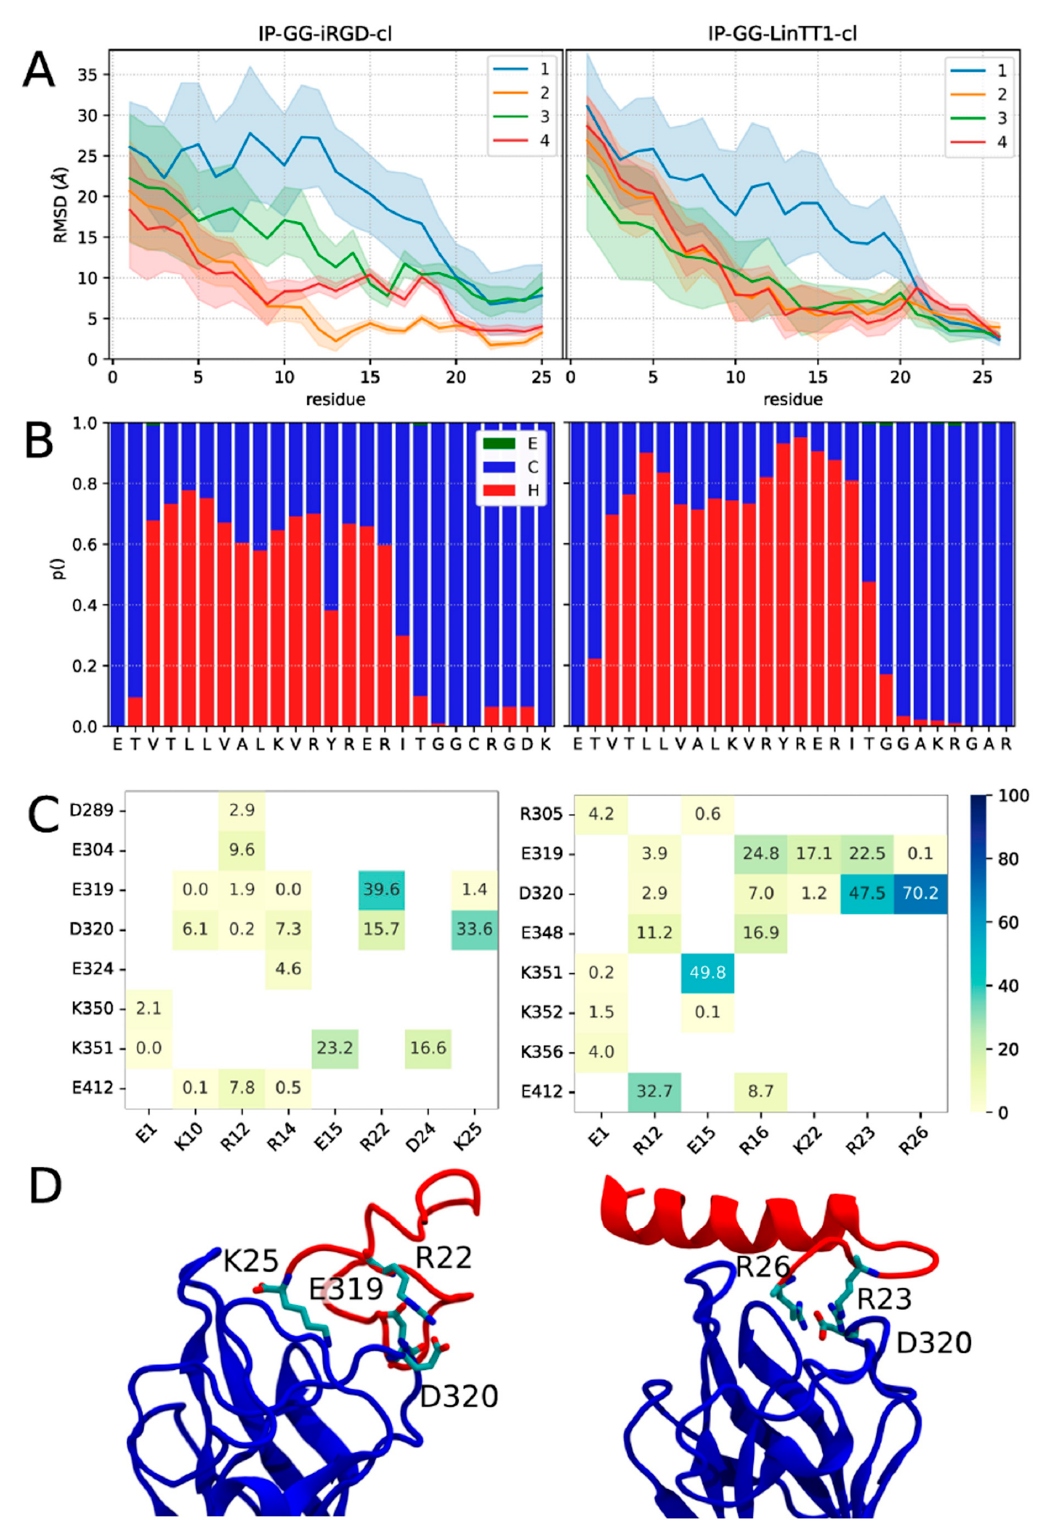
Figure 2. Cleaved Peptide stability secondary structure and interaction with Neuropilin1. ( A ): Peptide RMSD per residue of IR-GG-iRGD-cl and IR-GG-LinTT1-cl, colored by simulation replica; error bar represents the standard deviation of RMSD. ( B ) Secondary structure percentage of IR-GG-iRGD-cl and IR-GG-LinTT1-cl (E, C and H stand for extended strain, coil and helix secondary structure, respectively). ( C ) Frequency of salt bridge interaction between Neuropilin1 ( y -axis) and peptides ( x -axis). Only salt bridges with frequencies higher than 0.01 are shown. ( D ) Representative structure of the biggest cluster. All MD simulation frames were clustered based on C-ter residue backbone